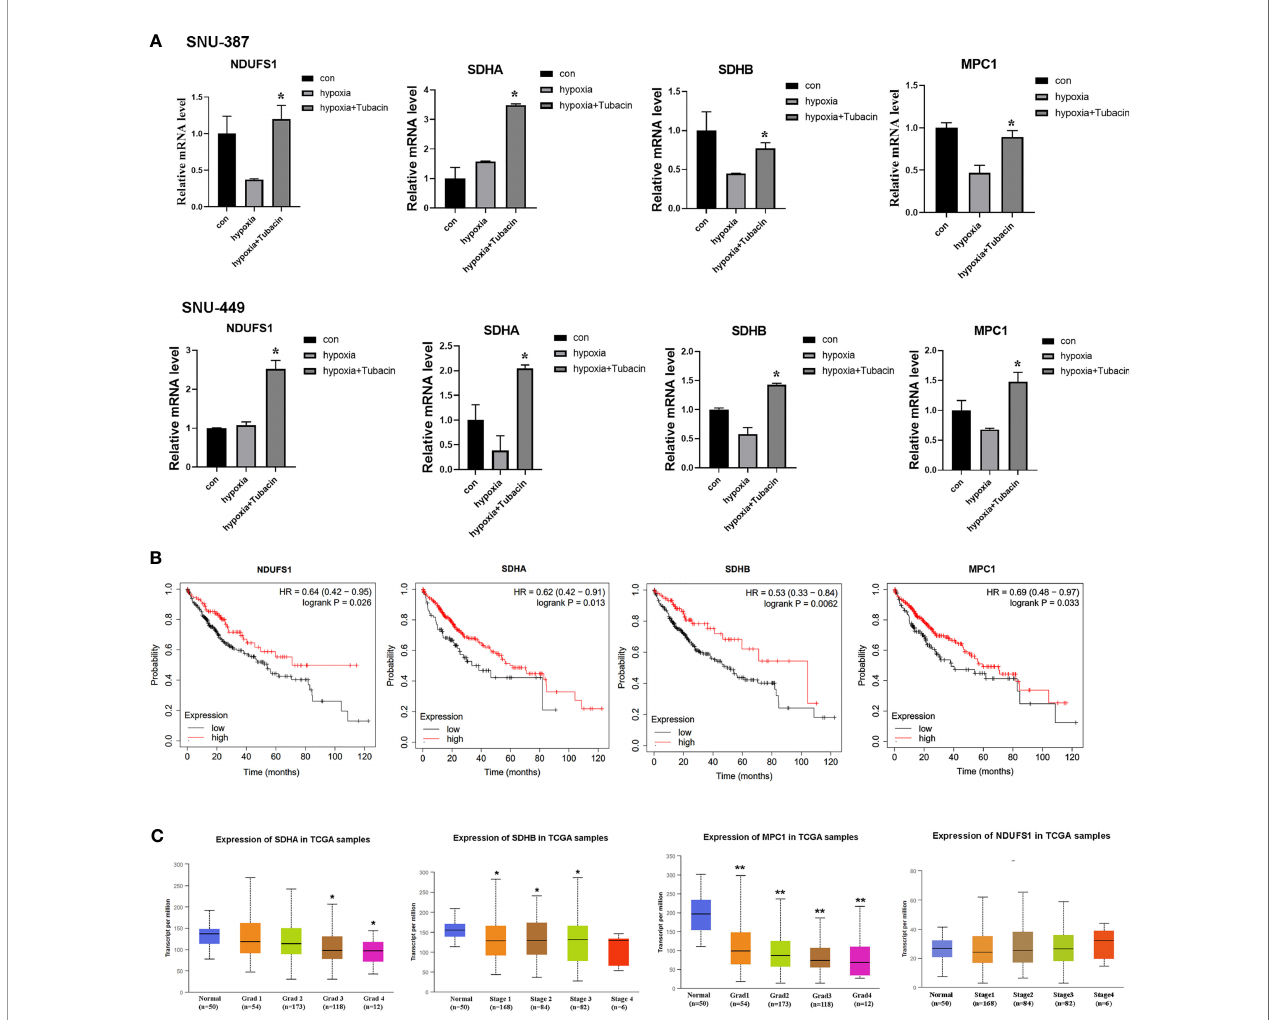
FIGURE 5 | HDAC6 inhibition elevated mitochondrial OXPHOS-related genes regulated by COUP-TFII in HCC. (A) SNU-387 and SNU-449 cells were treated with Tubacin for 12h under hypoxia and mRNA level of NDUFS1, SDHA, SDHB and MPC1 were analyzed (means ± SD, n = 3, *P < 0.05 versus the hypoxia group). (B) Kaplan-Meier survival analysis was conducted to assess the NDUFS1, SDHA, SDHB and MPC1 expression in liver hepatocellular carcinoma. (C) Investigation of SDHA, SDHB MPC1 and NDUFS1 expression in different histologic grade of liver hepatocellular carcinoma, * P < 0.05, ** P < 0.01 versus normal